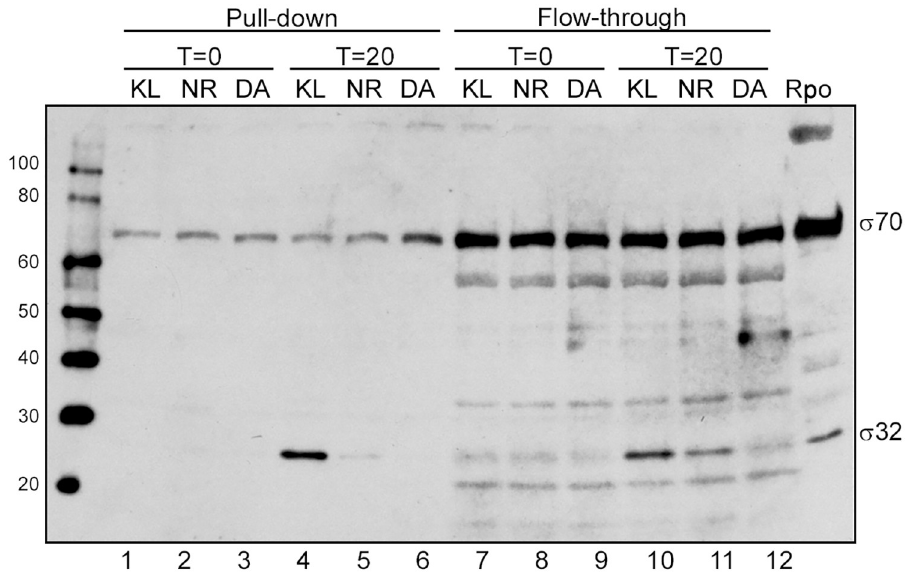
Fig 5. Excess σ 32 that accumulates following ARF48 induction associates with RNA polymerase. ARF48 and the ARF-NR and ARF-DA variant polypeptides were expressed in an E . coli strain that produces RNA polymerase containing a 6-histidine-tagged β 0 subunit [34]. Samples of culture were collected immediately before induction (T = 0) and 20 min after ARF protein induction (T = 20), and equal amounts of protein (100 μ g) were incubated with Ni-NTA beads as indicated in the Methods section. Samples of the bound (Pull-down) and unbound (Flow-through) fractions were then electrophoresed in an SDS-polyacrylamide gel, transferred to an immobilon membrane, and then probed with antibodies specific for σ 70 and σ 32. An identical set of samples run in parallel on a separate gel that was then stained with Coomassie blue showed that equal amounts of RNA polymerase (RpoB and RpoC subunits) were present in each sample (S5